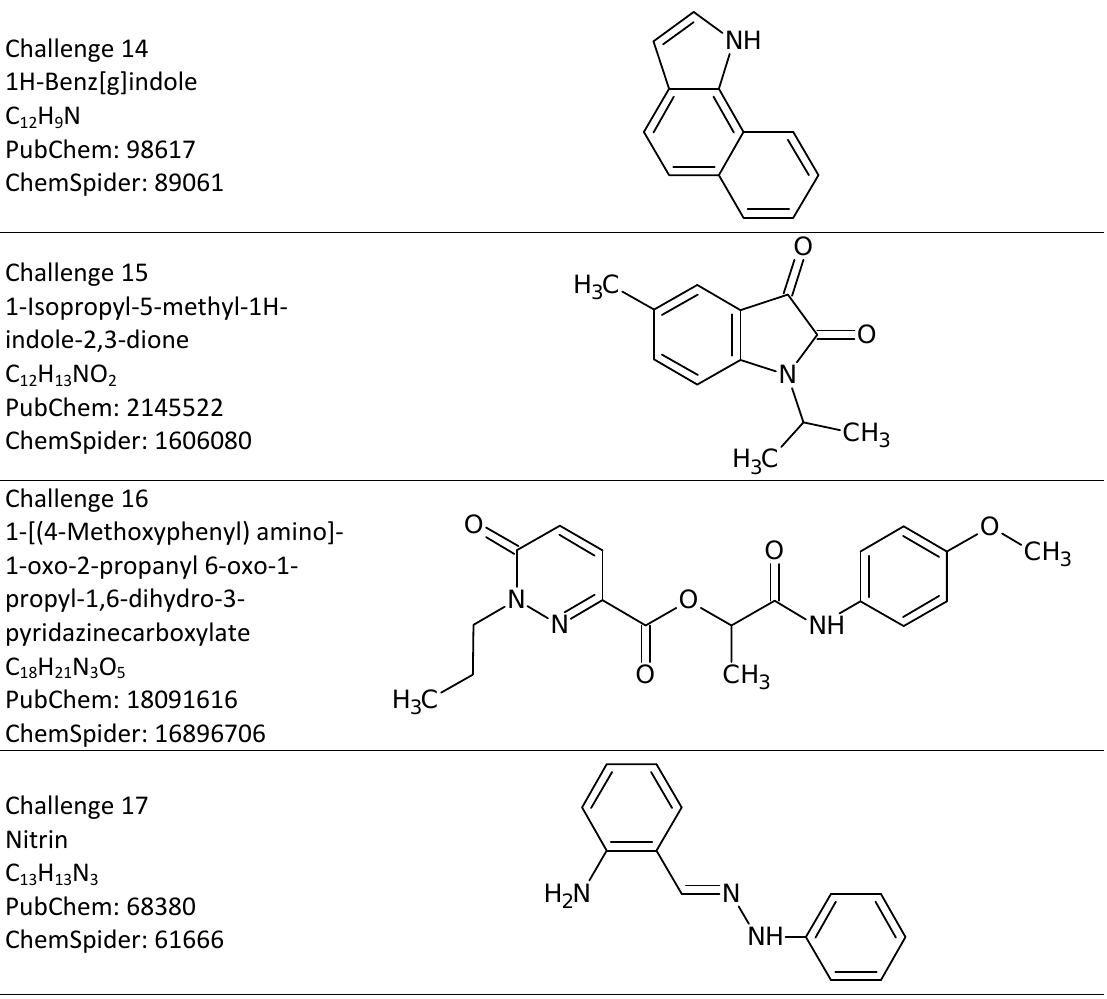
Figure B17. Structures and identifiers for LC-HRMS Challenges